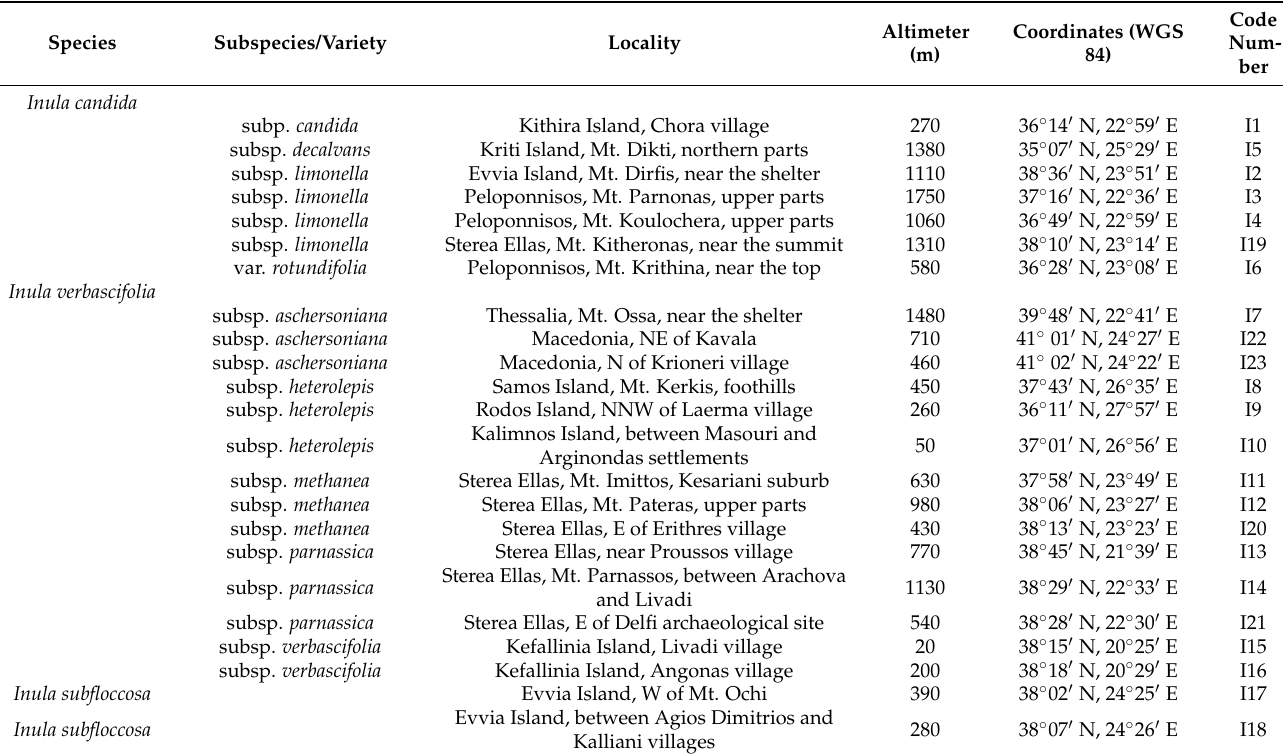
Table 1. The populations of the Inula candida/I. verbascifolia group investigated, with localities, altimeter, and coordinates. The code number of the last column is also used as an identifier in the chemical and cluster